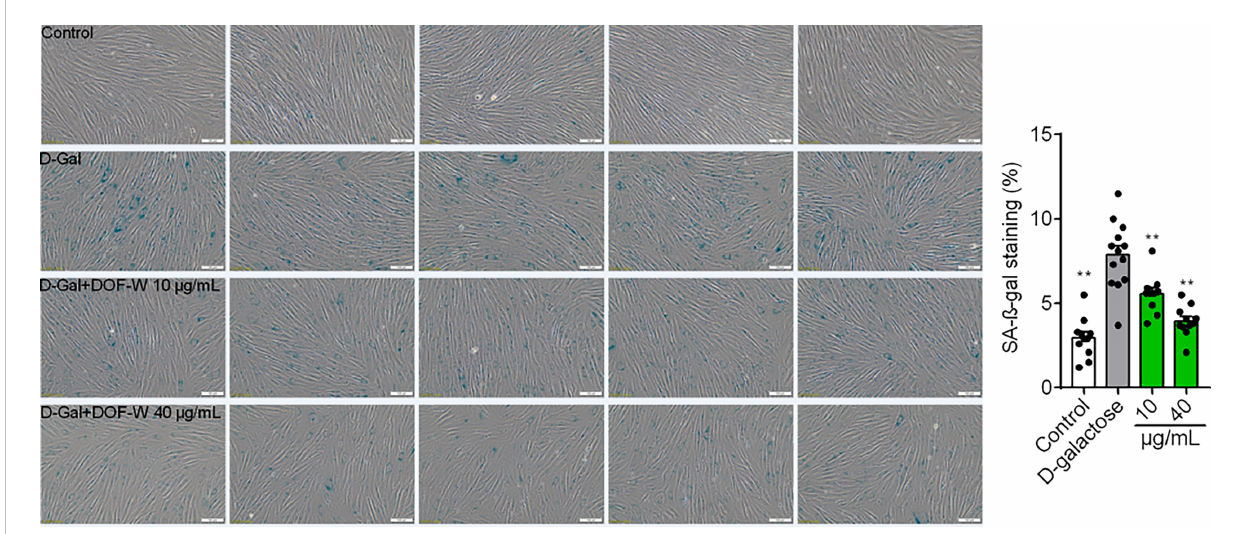
FIGURE 6 Images of fi broblasts with SA- b -gal staining. Statistics results of fi broblasts with SA- b -gal staining. Bar scale, 100 m m. Compared with the model group, ** p<